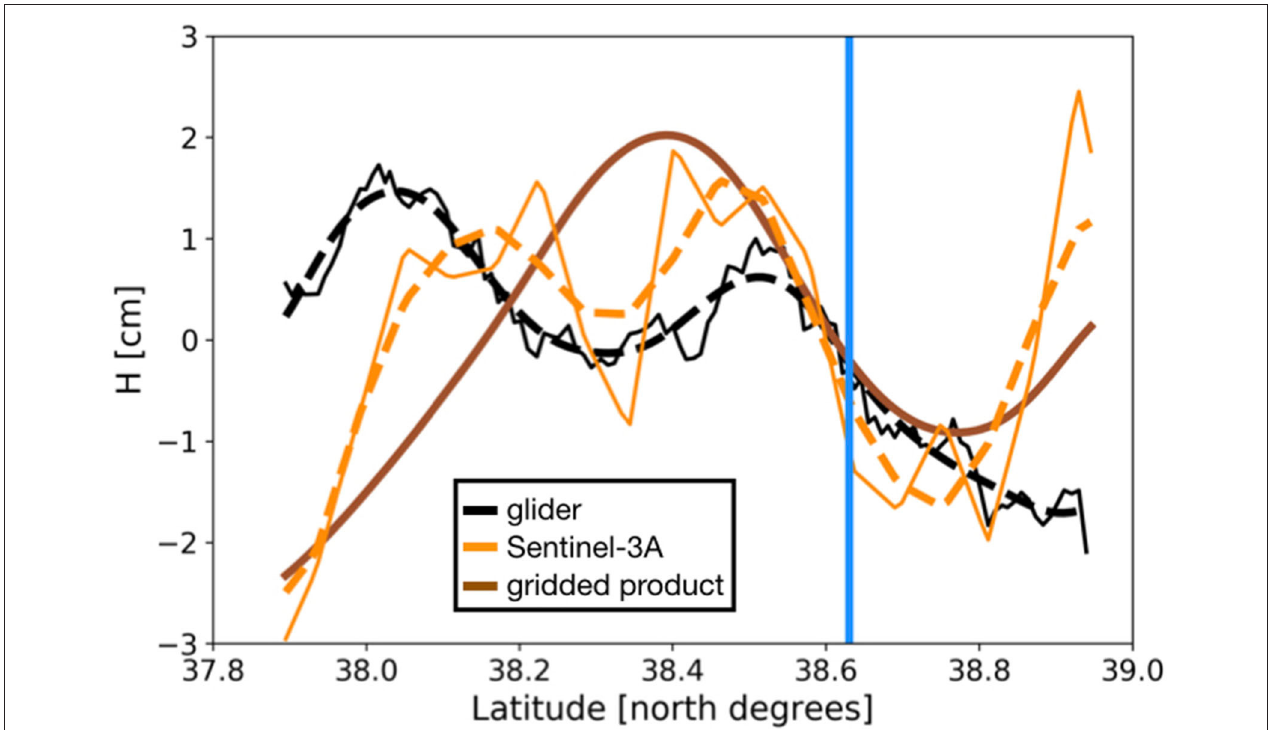
FIGURE 11 | Filtered (dashed black thick line) and unfiltered (solid black thin line) DH from glider data along ground-track 244 associated with the date of passage of the Sentinel-3A satellite over the Algerian Basin on 13 May 2018. Filtered (dashed orange thick line) and unfiltered (solid orange thin line) ADT from the Sentinel-3A along-track European reprocessed product, and ADT computed from the Mediterranean Sea reprocessed altimetry gridded product (brown line). Since the reference level used to compute the DH is different from the reference level used in altimetry, the mean value of each variable has been removed to better compare all variables. The blue vertical line shows the location of the glider during the Sentinel-3A